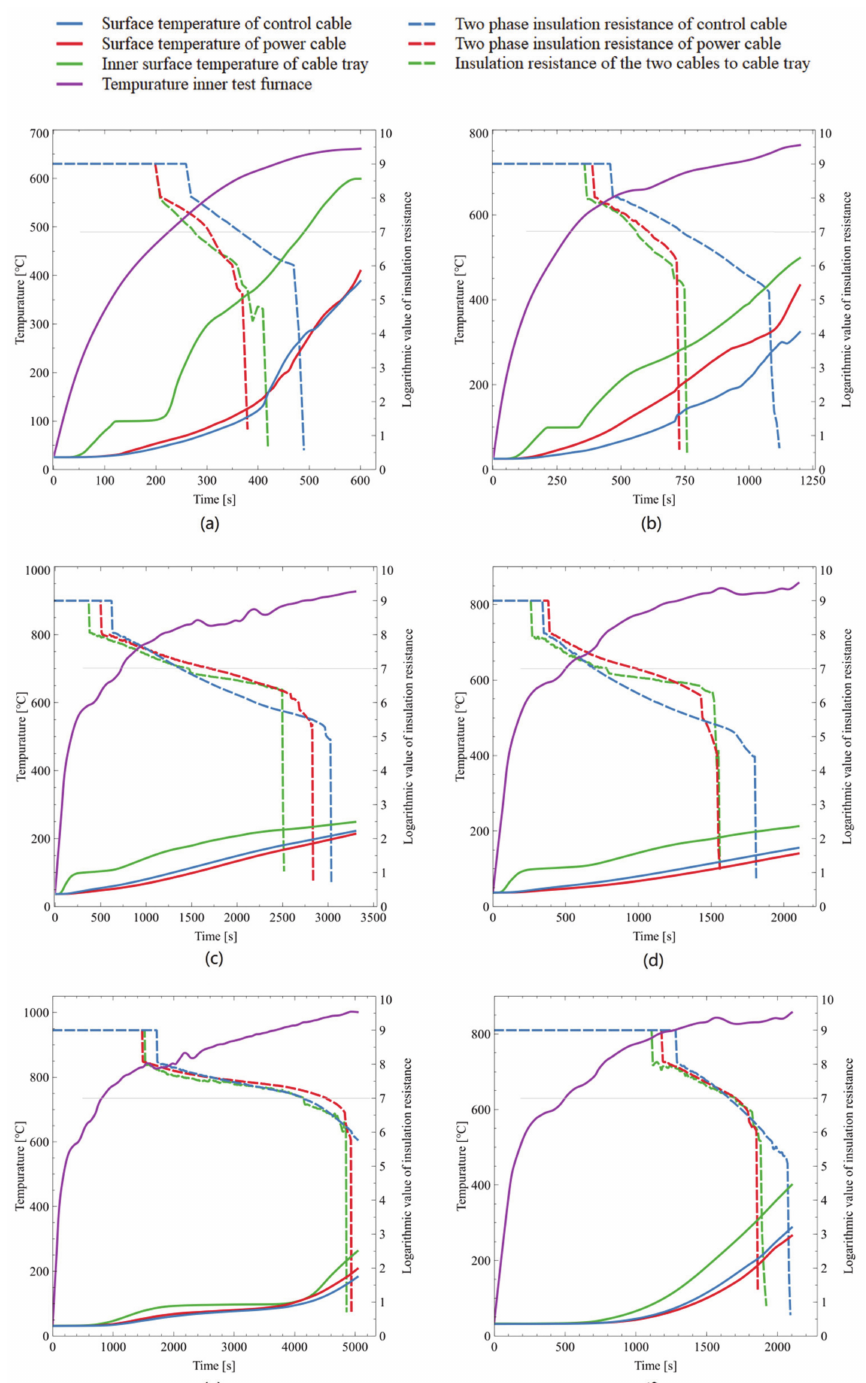
Figure 7. Temperature and logarithmic value for insulation resistance-time curve: ( a ) curves of case 1; ( b ) curves of case 2; ( c ) curves of case 3; ( d ) curves of case 7; ( e ) curves of case 8; ( f ) curves of case